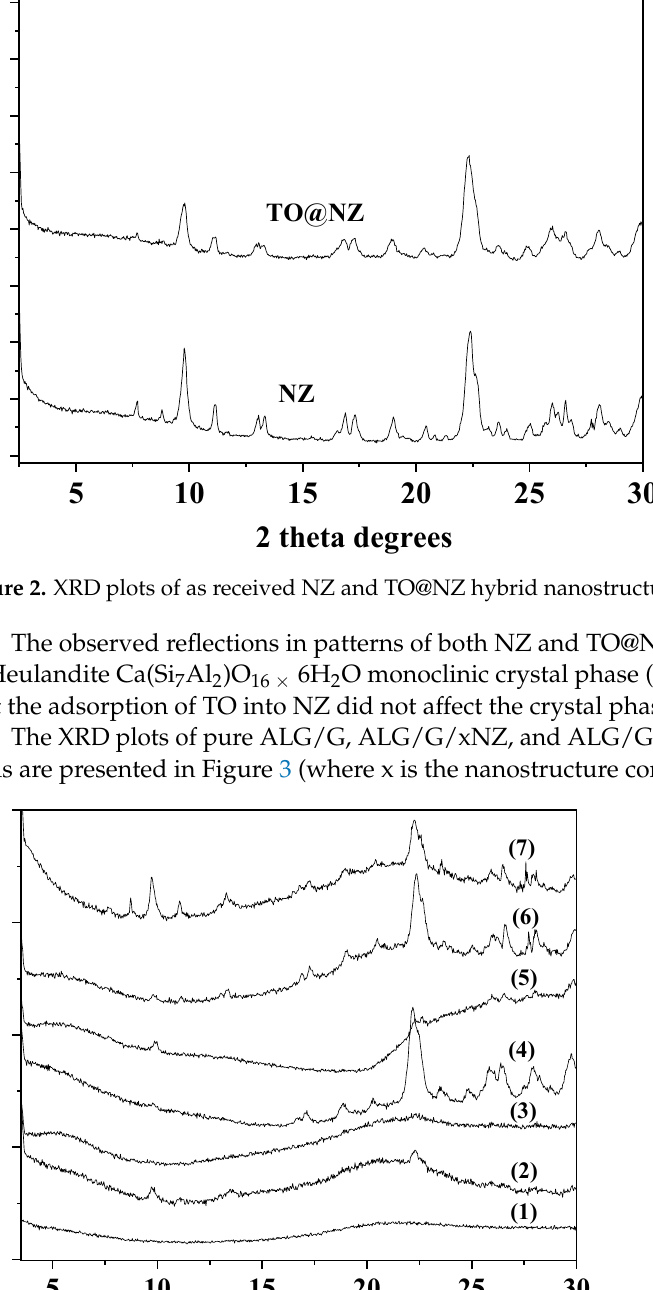
Figure 3. XRD plots of: (1) ALG/G, (2) ALG/G/5NZ, (3) ALG/G/10NZ, (4) ALG/G/15NZ, (5) ALG/G/5TO@NZ, (6) ALG/G/10TO@NZ AND (7) ALG/G/15TO@NZ obtained films. Unplasticized alginate films exhibited two broad peaks with central positions at 2 θ = 13.5° and 21.6° [36,37]. As it is observed in Figure 3, in the case of such ALG/G films the peak at 2 θ = 13.5° disappeared indicating a lower proportion of the amorphous structure with larger chain distances. This is a result of water and glycerol de-structuration [36]. No changes of the ALG crystallinity were observed with the addition of either NZ or TO@NZ hybrid nanostructures. Moreover, after an initial additive loading into the polymeric ma- trix, as the % wt. content of NZ or TO@NZ hybrid nanostructure increases the reflections of zeolite’s crystal phase are increase. This indicates that the higher dispersion of such materials in the ALG/G film is obtained only for low % wt. loadings i.e., <10% wt. 2.4. FTIR Spectroscopy Line (1) in Figure 4 represents the FTIR spectra of the as received TO. In the same figure, Line (2) is assigned to the as received natural zeolite FTIR spectra, and Line (3) to the modified rich in thymol natural zeolite TO@NZ.